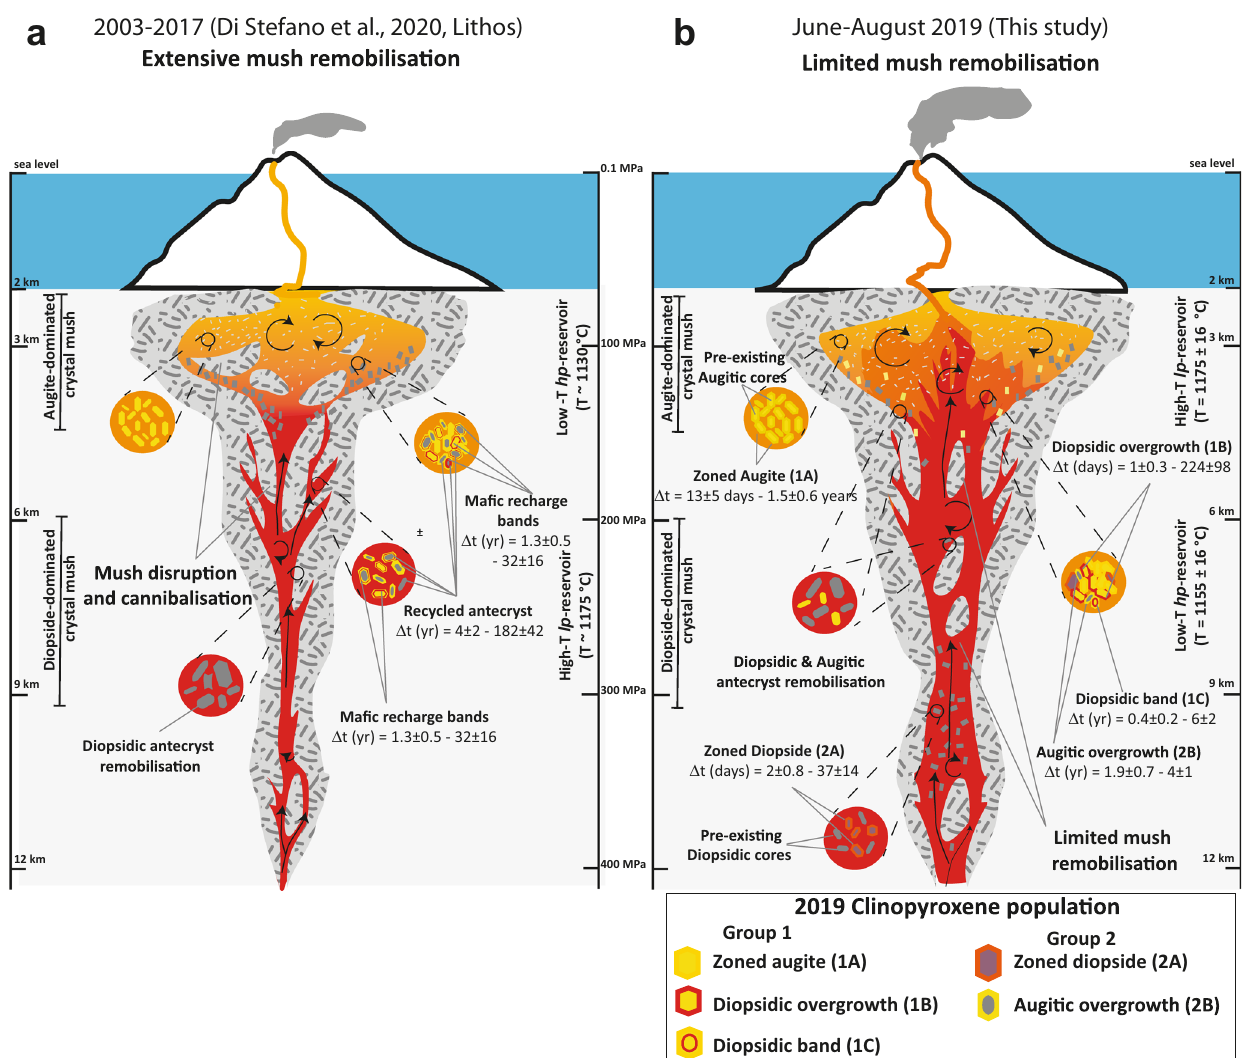
Fig. 7 | Schematic model of the plumbing system at Stromboli volcano. a 2003 – 2017 eruptive periodadaptedfrom DiStefanoet al.; 3 b June – August 2019 (this study). During the 2003 – 2017 eruptive period extensive mush remobilisa- tion and cannibalisation operated by the uprising deeper undegassed ma fi c recharge lp -magma (in red) characterises magma dynamics. The lp -magma is fed by the deeper reservoir as inferred by Métrich et al. 21 . Abundant recycled diop- sidic antecrysts are remobilised from the crystal mush and transported by the lp - magmas permeating the mush, into the shallower hp -reservoir (yellow-orange). The continuous and ef fi cient remobilisation of the mush between 2003 and 2017 led to a rejuvenated plumbing system con fi guration in 2019, characterised by the lp -magma extensively permeating the mush with limited mush remobilisation. A few recycled diopsidic and augitic antecrysts are remobilised and transported by